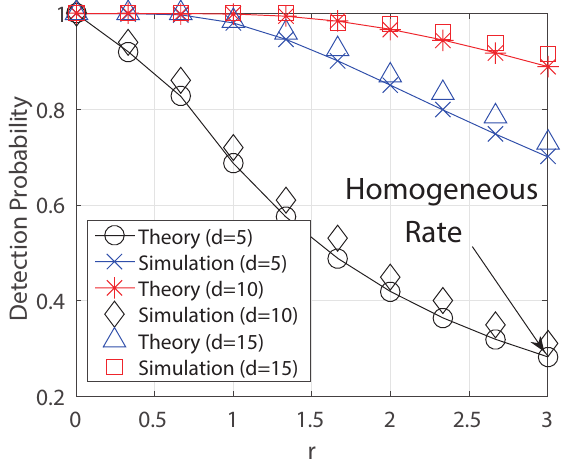
Figure 3. Theoretical and simulation result for Theorem